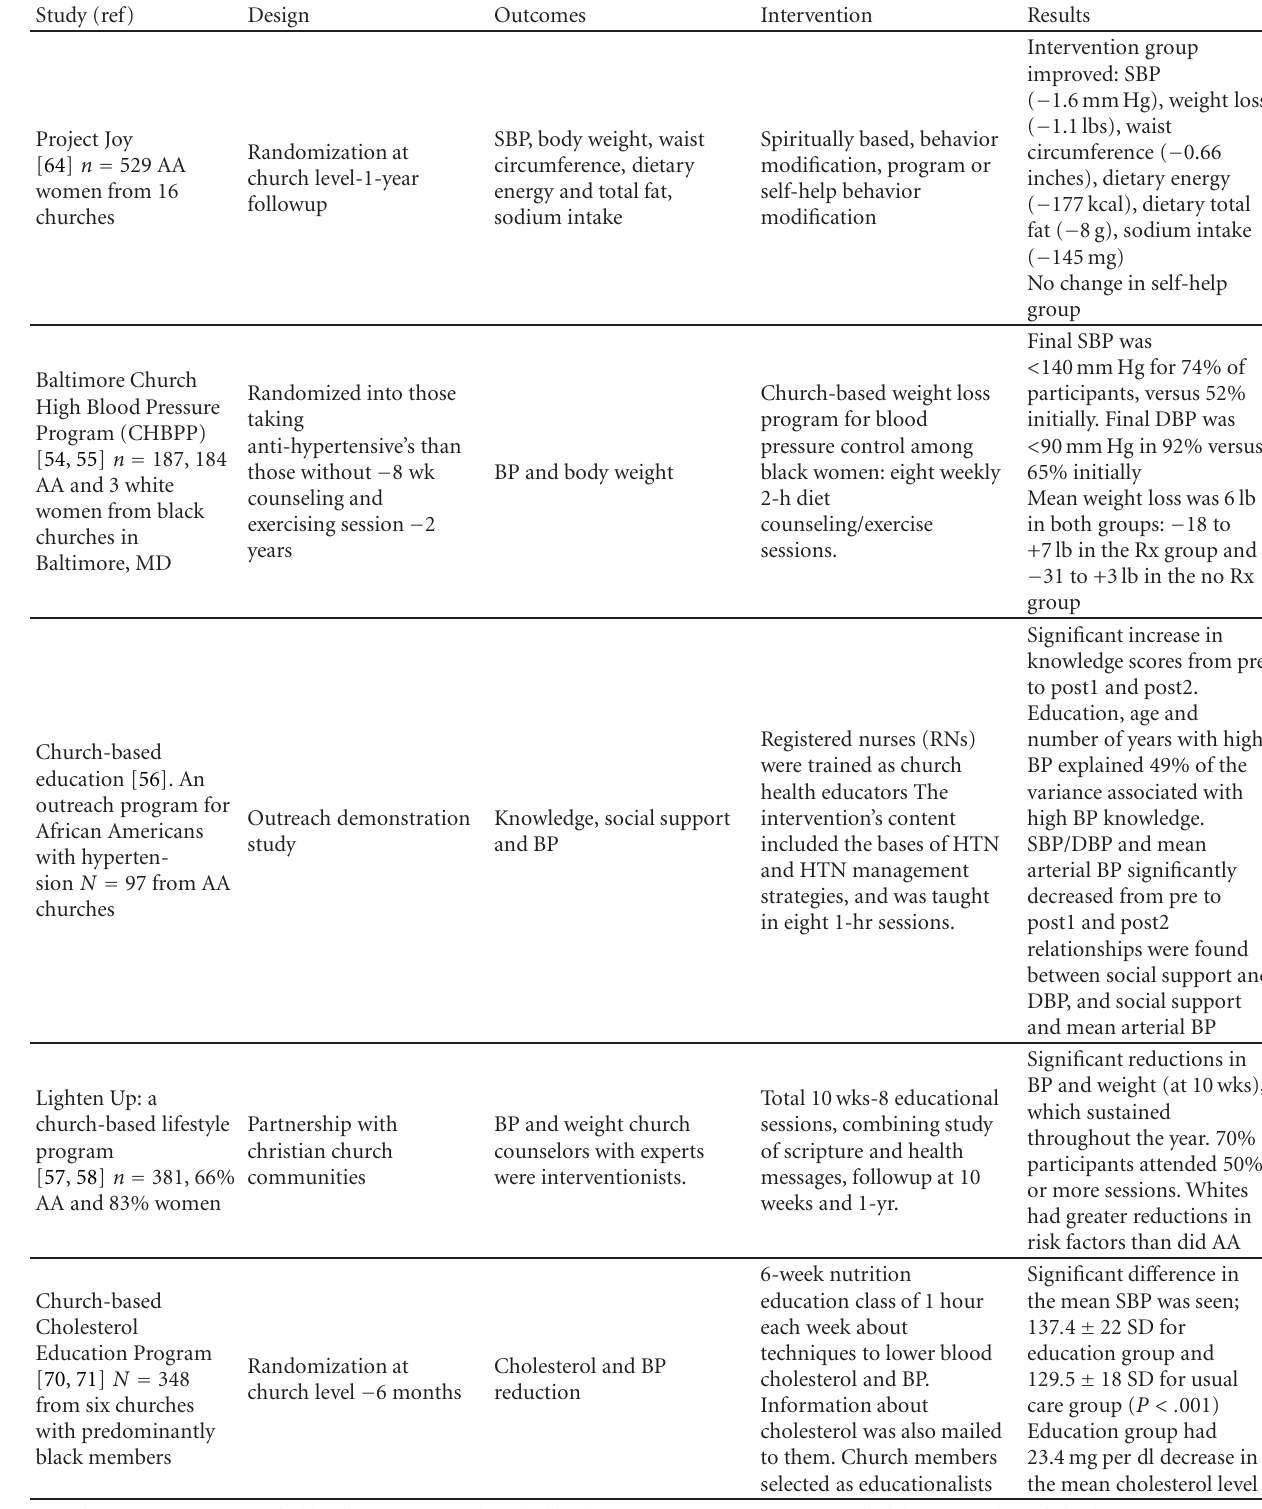
Table 1: Church-based participatory research interventions through African American